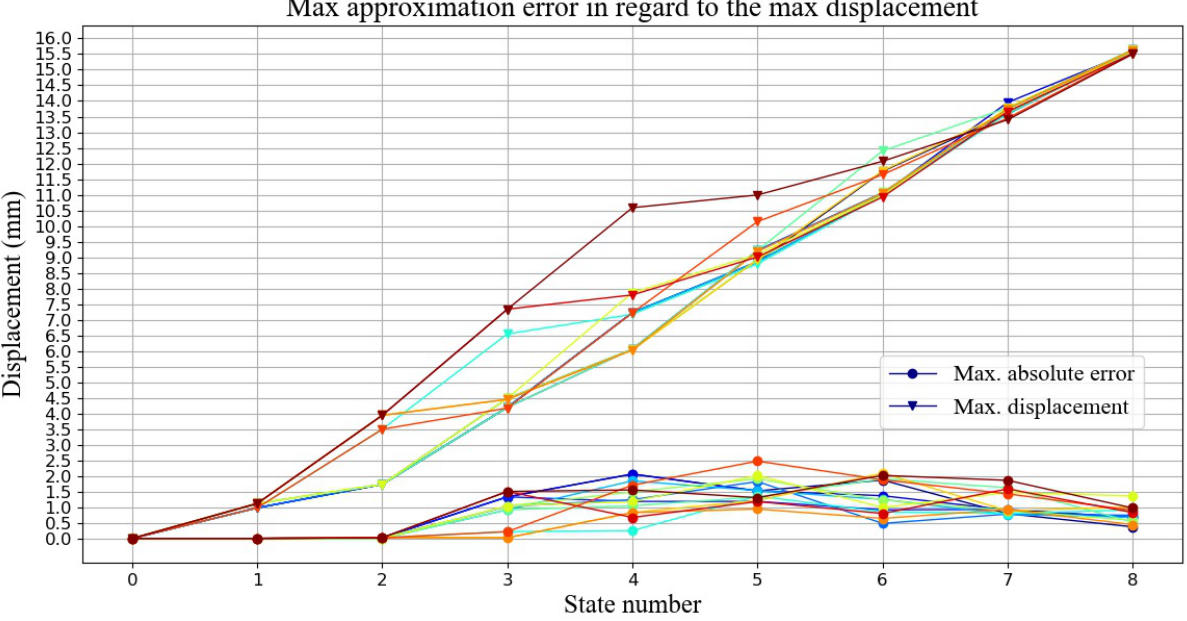
Figure 14. Maximum prediction error and maximum displacement for the MLP regression with topology